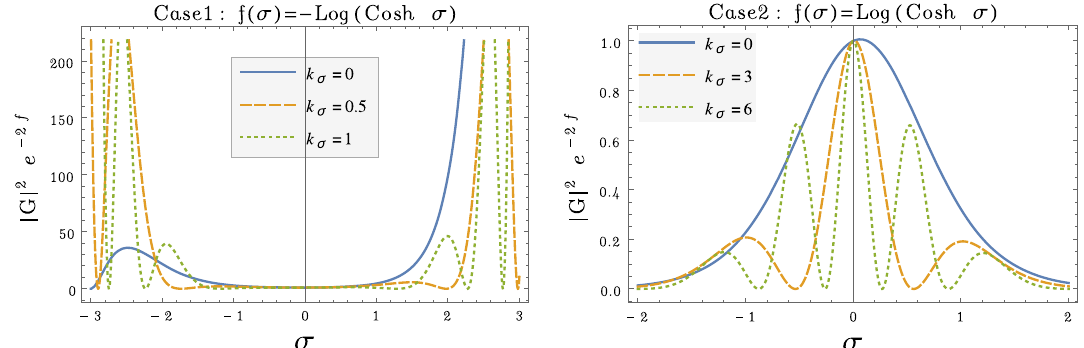
Fig. 1 Left: Variation of the overall pre-factor in presence of decaying warp factor for k σ = 0 , 0 . 5 , 1. Right: Variation of the overall pre-factor in presence of growing warp factor for k σ = 0 , 10 , 20